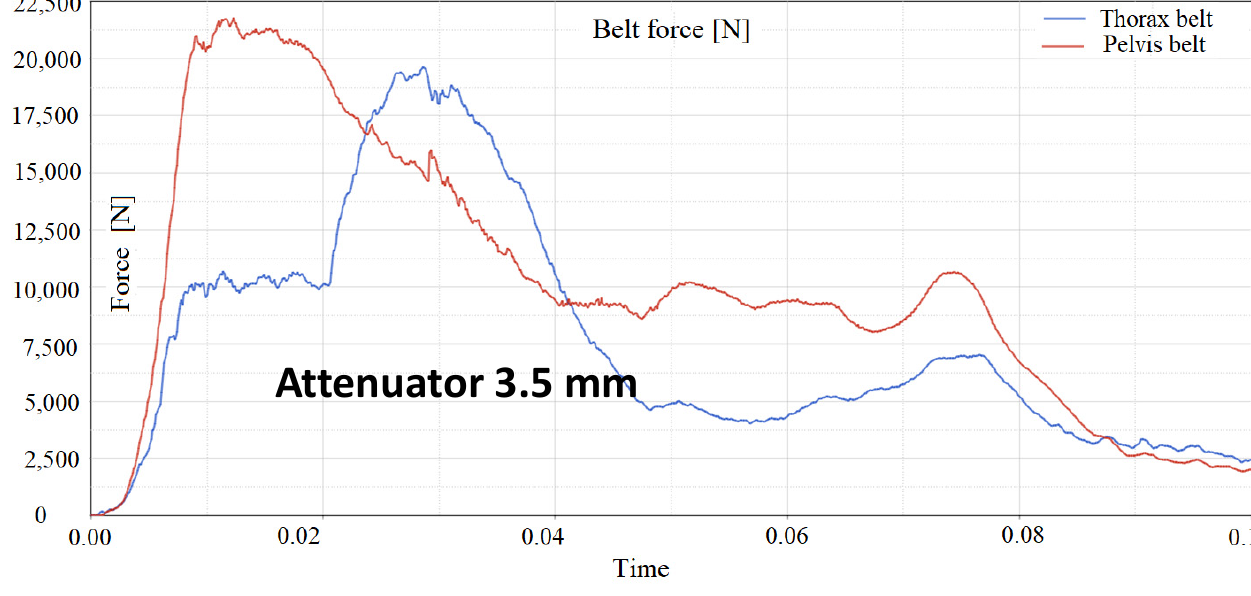
Figure 9. The forces in the thorax and pelvis belts. The shock absorber had a thickness of 3.5 mm.